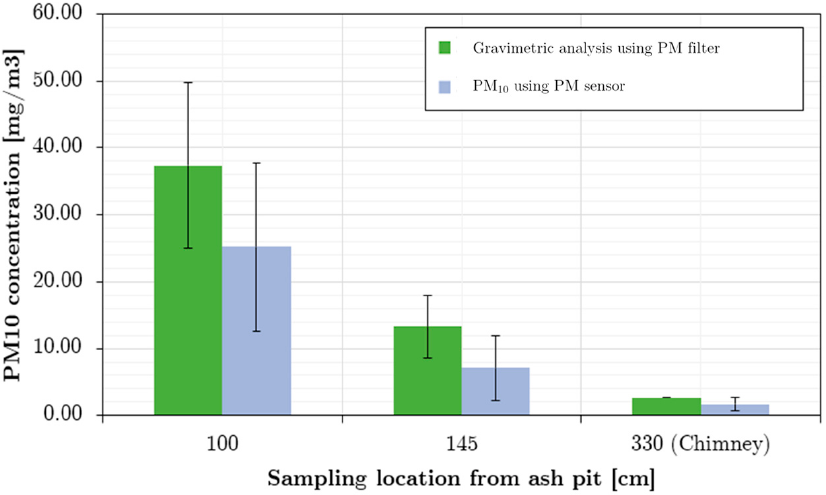
Figure 6. Comparison between PM filter N95 and PM sensor SDS011 at different sampling locations inside the furnace.